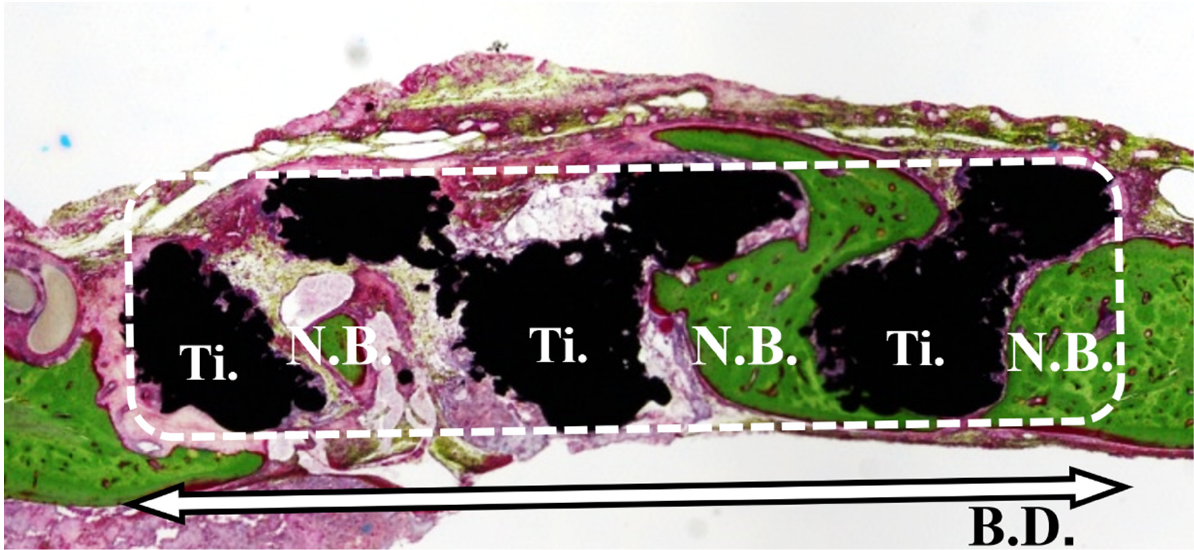
Figure 4. Bone volume ratio (%). Bone occupancy was calculated as the amount of newly formed bone in the space inside the bone defect.